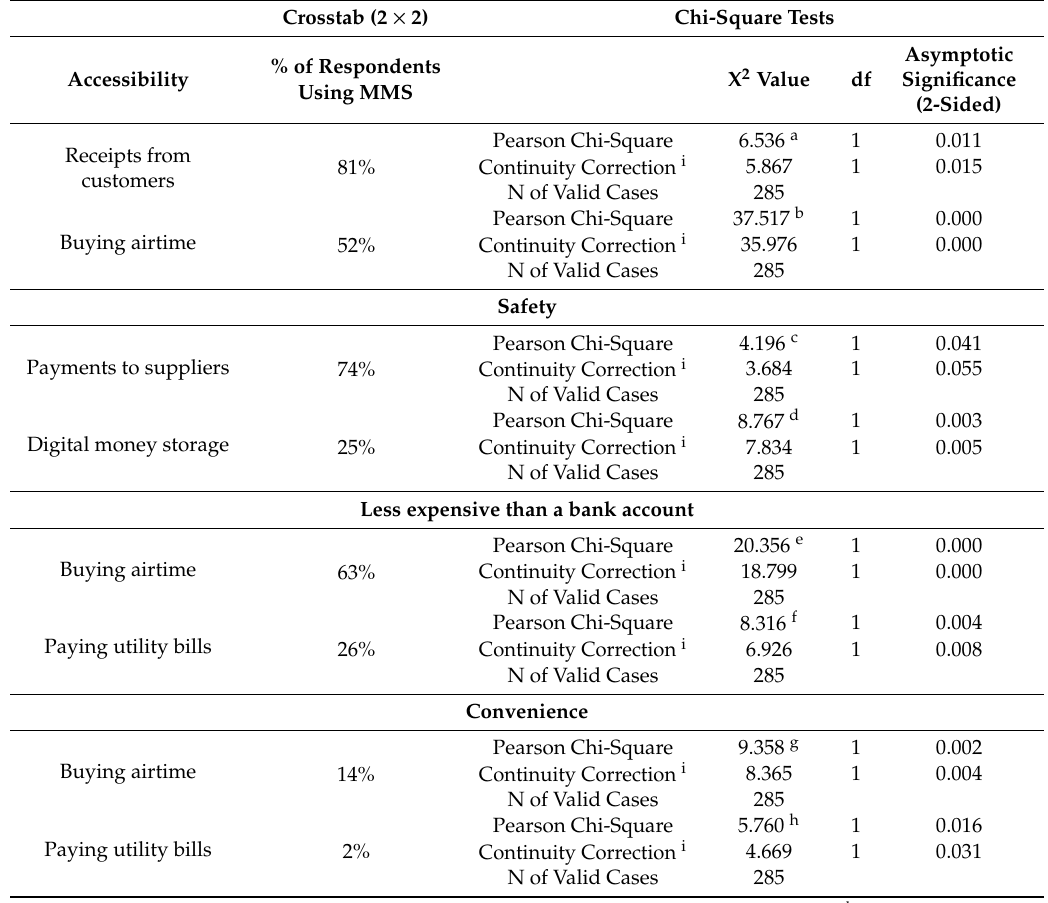
Table 5. Chi-square